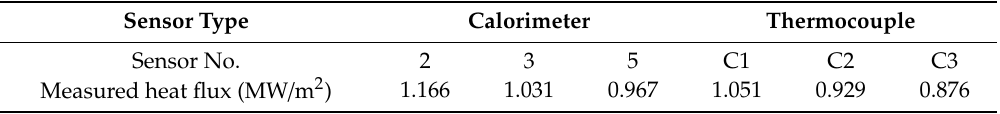
Table 2. Comparison of the heat flux obtained from the copper calorimeters and coaxial thermocouples at the same location in the arc tunnel.